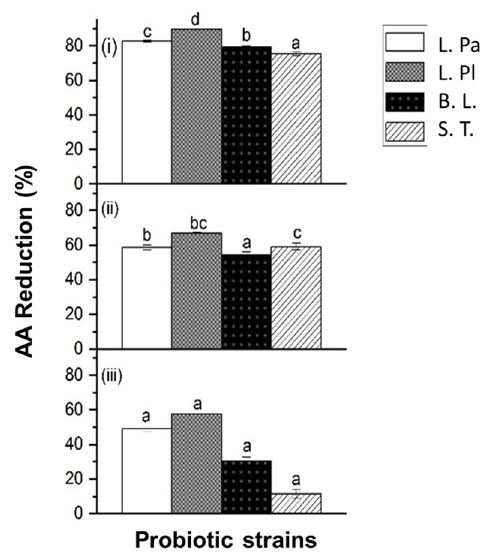
Figure 1. The acrylamide (AA) reduction ability of four single strains of probiotic bacteria: Lacticas- eibacillus paracasei ATCC25302 ( L. Pa. ), Lactiplantibacillus plantarum ATCC14917 ( L. Pl. ), Bifidobacterium longum ATCC15707 ( B. L. ), and Streptococcus thermophilus ATCC19258 ( S. T. ), when exposed to ( i ) 350 ng/mL, ( ii ) 750 ng/mL, and ( iii ) 1250 ng/mL AA solutions. Probiotic concentration was 10 9 CFU/mL. Incubated at 37 °C for 4 h at pH 6.5–7.0. Expressed as AA reduction percentage. Different characters in the same panel indicate significant differences, whereas the same character indicates not significant.